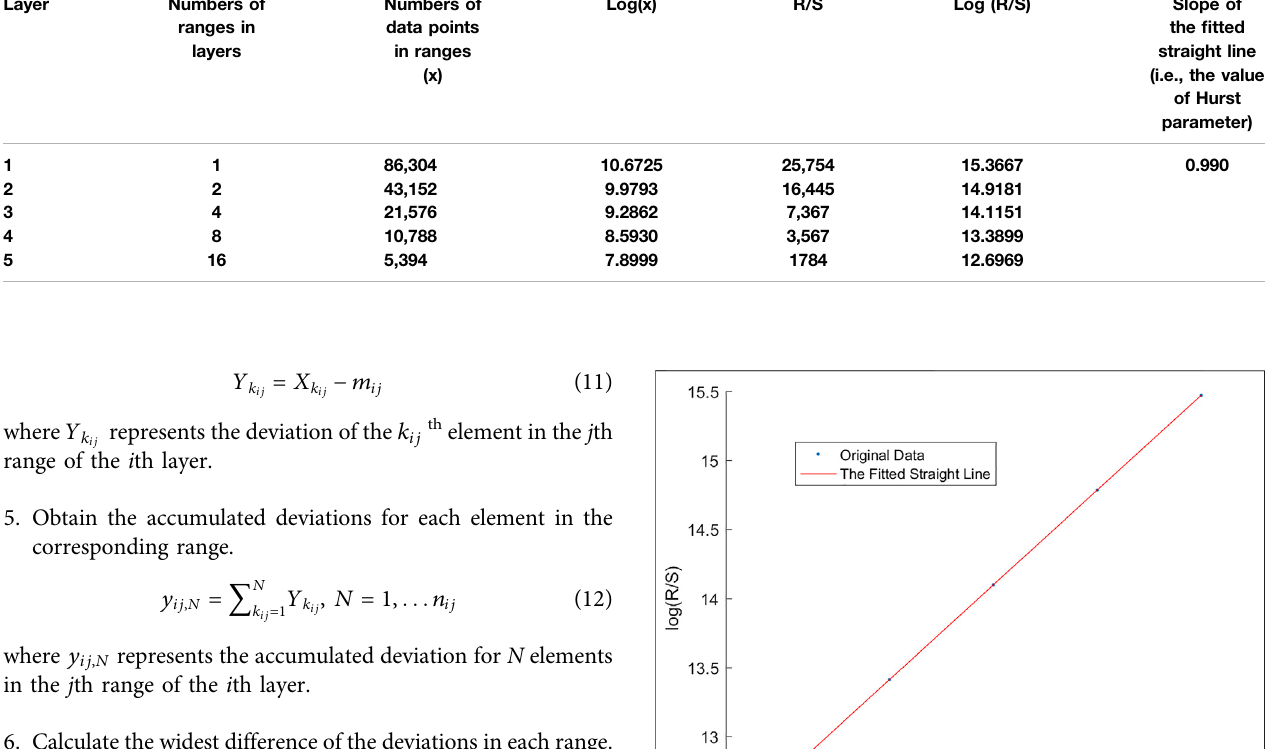
Numbers of data points